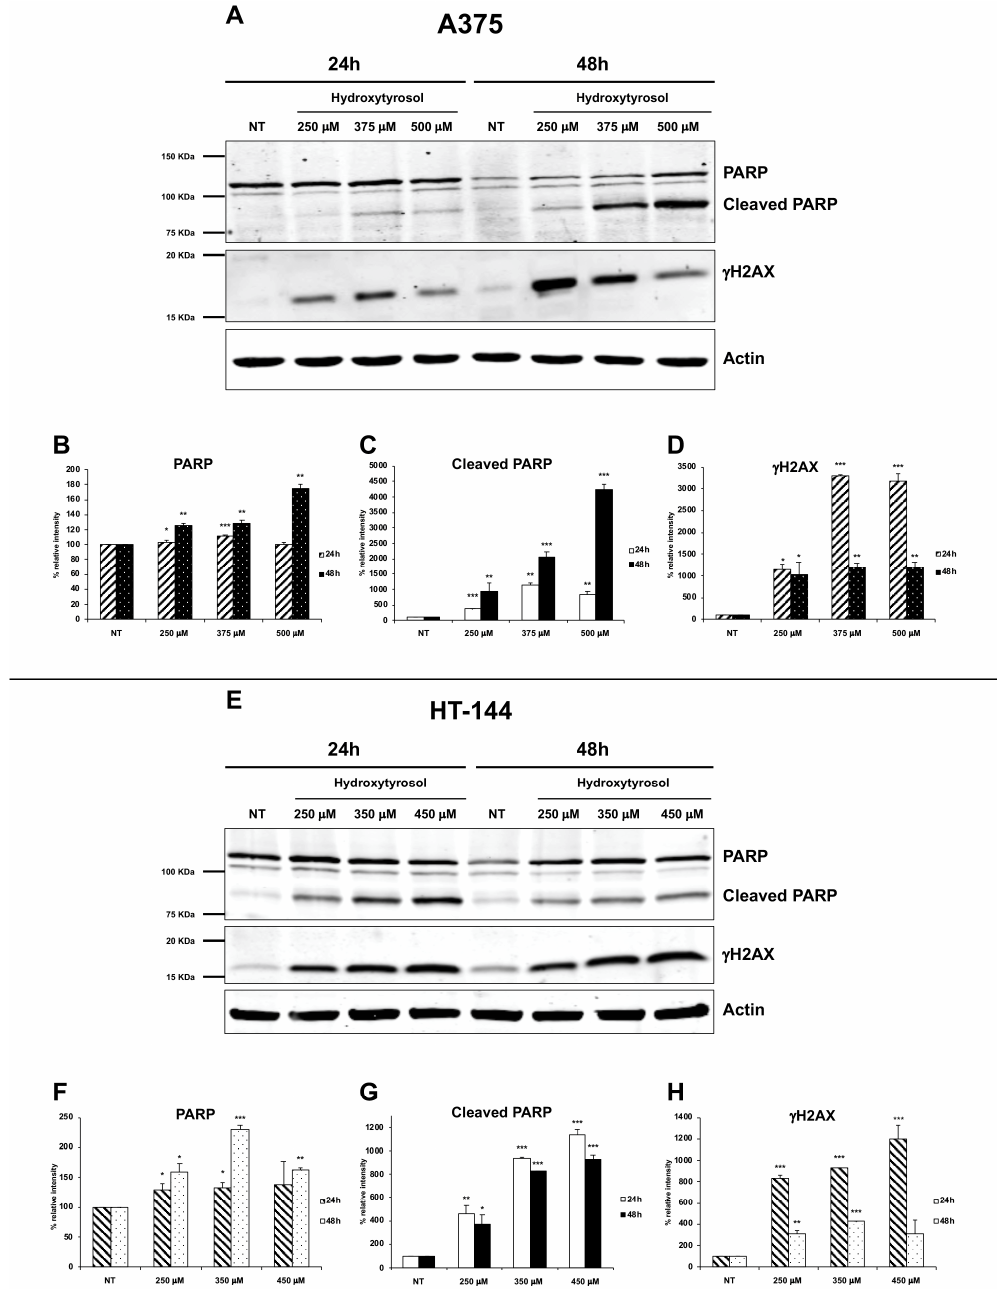
Figure 7. Expression of PARP-1 and γ H2AX in hydroxytyrosol treated melanoma cells. A375 cells ( A – D ) were treated with 250 µ M, 375 µ M, and 500 µ M of hydroxytyrosol and HT-144 cells ( E – H ) were treated with 250 µ M, 350 µ M, and 450 µ M of hydroxytyrosol for 24 h and 48 h. The expression of PARP-1 ( A , E , upper panels, B , F ), of the cleaved form of PARP-1 ( A , E, upper panels, C , G ), and of γ H2AX ( A , E , middle panels, D , H ), was analysed in A375 and in HT-144 cell lines in response to the treatment with hydroxytyrosol through western blot experiments. The equal protein loading was confirmed by the analysis of β -actin expression ( A , E , lower panels). The data are representative of several western blot experiments. The error bars indicate the standard deviation. Statistical significance was analysed by Student’s t -test: * p < 0.05 was considered significant; ** p < 0.01 highly significant; *** p < 0.001 very highly